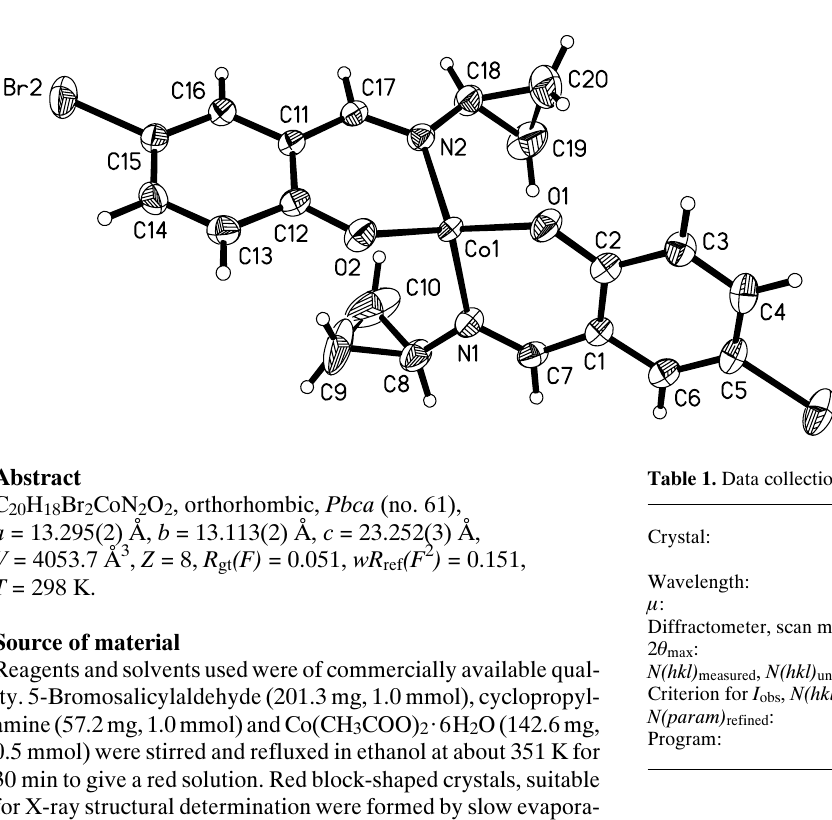
Table 2. Atomic coordinates and displacement parameters (in Å 2 )